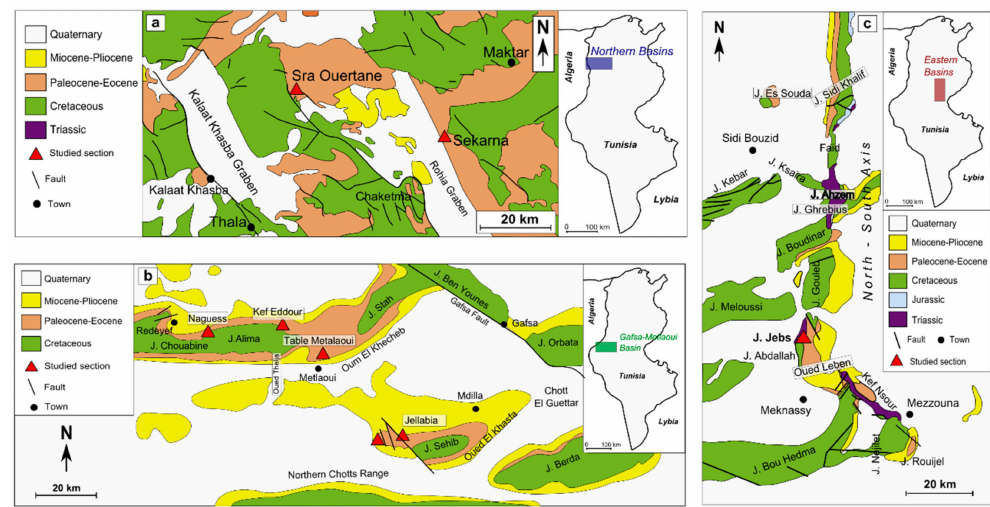
Figure 3. Schematic geological maps of the ( a ) northern, ( b ) Gafsa-Metlaoui, and ( c ) eastern Tunisian basins affected by Paleocene–Eocene phosphogenesis. Modified after Ben Haj Ali et al. [34] and Garnit et al.